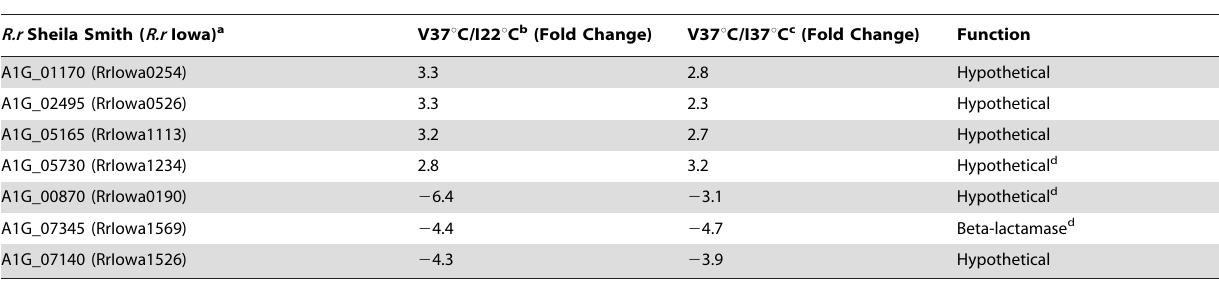
Table 6. Transcriptional differences between Vero and ISE6